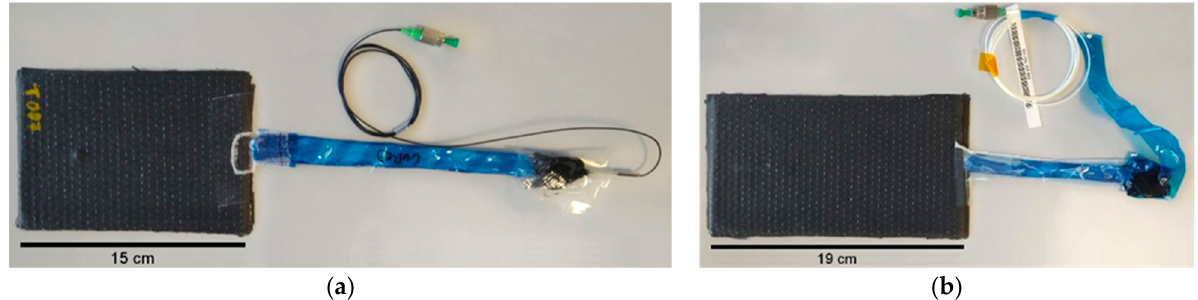
Figure 1. Schematic of optical fibre through − thickness embedding locations.